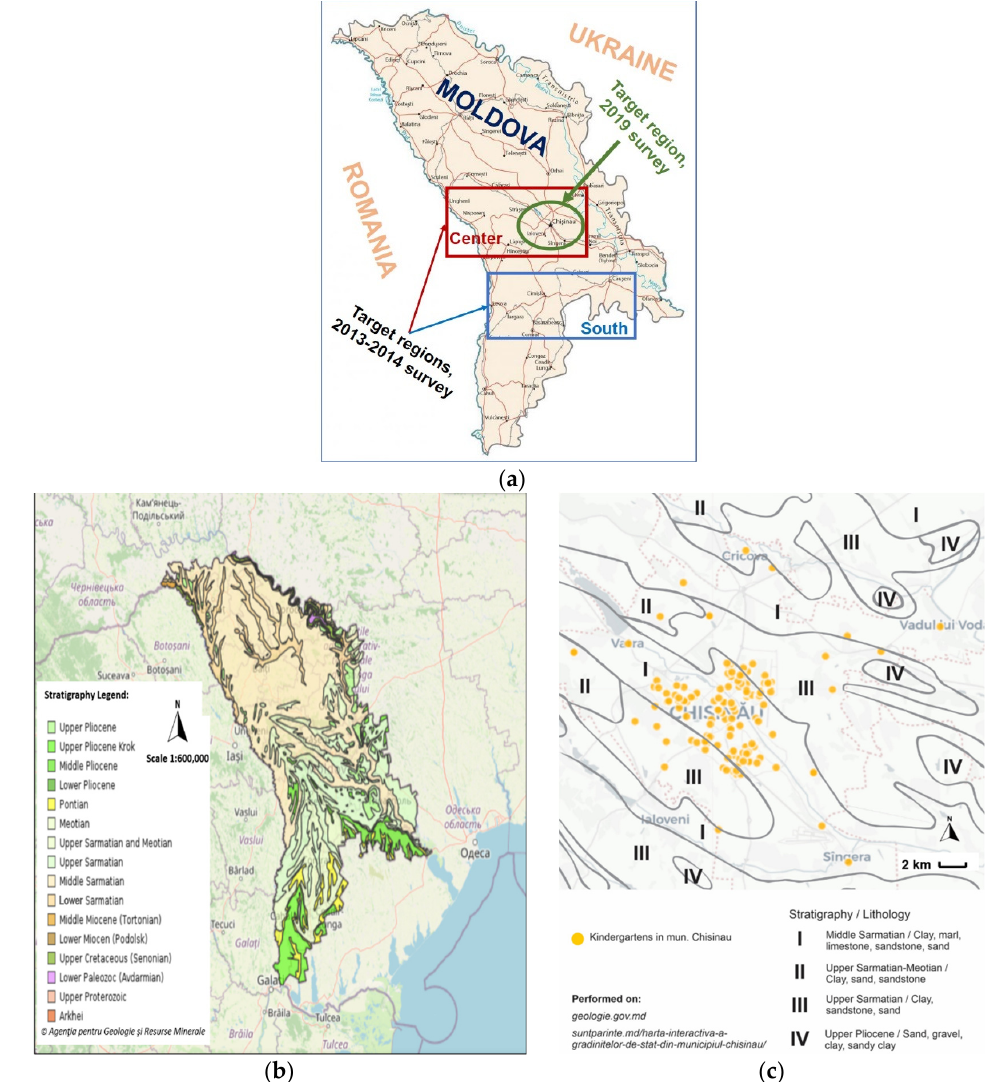
Figure 1. ( a ). Map of the studied areas in the Republic of Moldova; ( b ) Geological map of the Republic of Moldova (available on-line [44]); ( c ) Geological map of the Chisinau region and distribution of the target buildings in the 2021 survey.